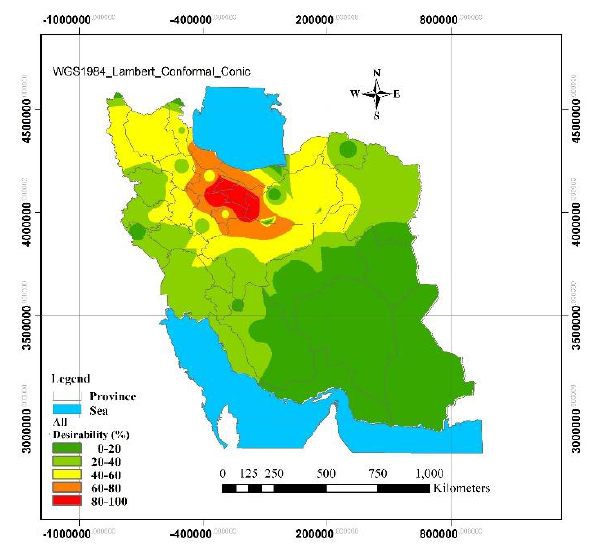
Figure 6- Site selection map of “all”